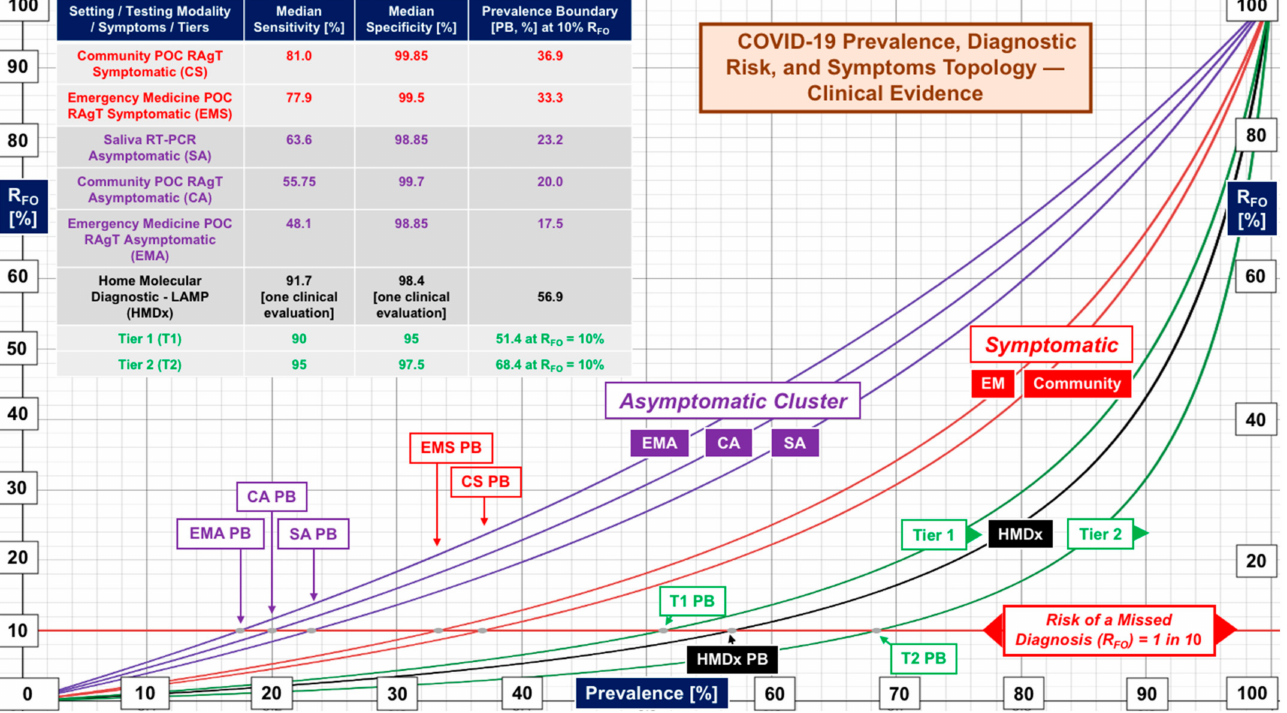
Figure 7. False omission rate topology for asymptomatic and symptomatic subjects. The purple cluster shows performance for asymptomatic subjects in emergency medicine (EMA) and community (CA) settings, while the red cluster reflects results for symptomatic subjects. Saliva testing for asymptomatic subjects (SA, purple), with specimen collection at points of need and PCR analysis performed in laboratories, did not differ substantially from rapid antigen testing. “ HMDx ” represents one clinical evaluation of molecular self-testing, which achieved performance between Tier 1 and Tier 2. In this case the risk of a missed diagnosis (R FO ) is 10%, shown by the red horizontal